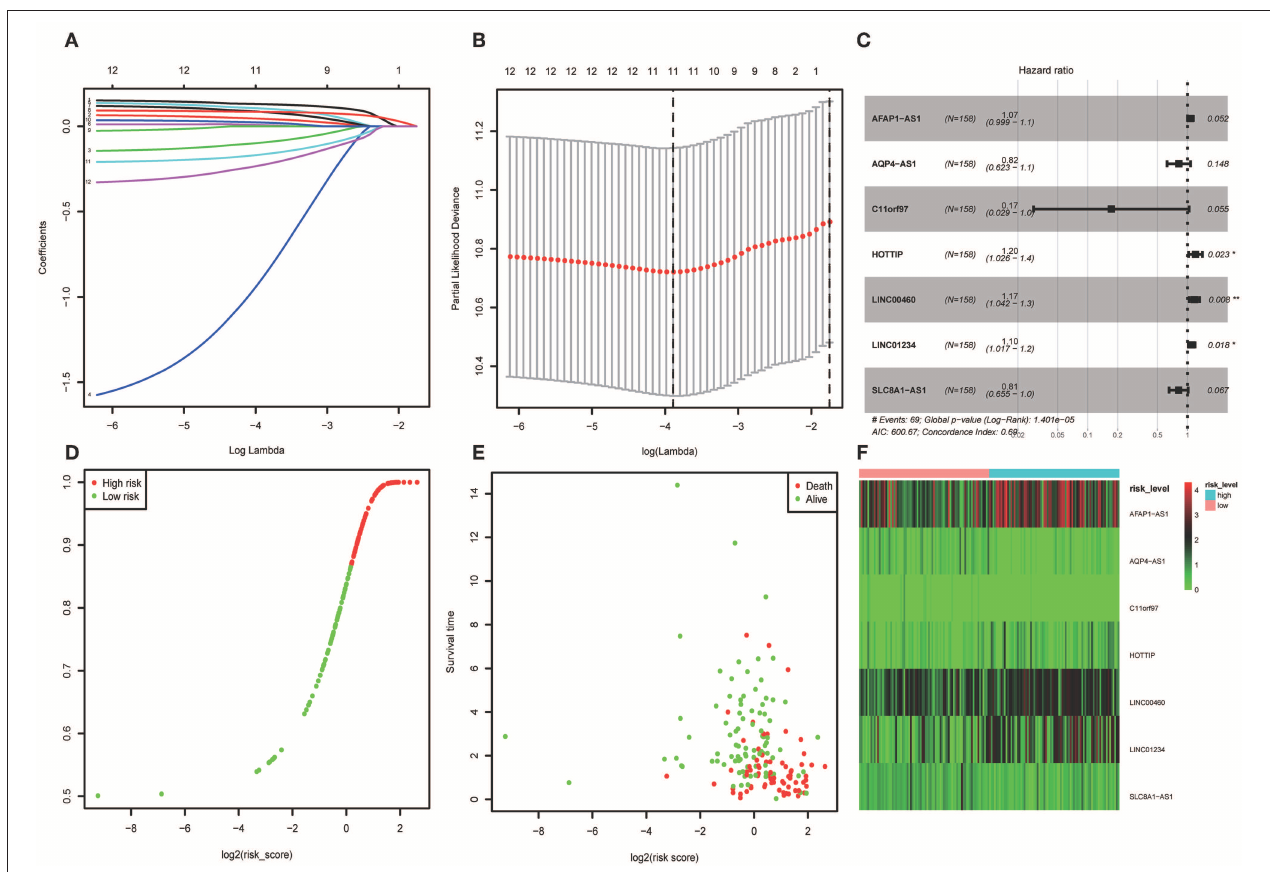
FIGURE 5 | (A) LASSO coefficient profiles of the genes associated with the overall survival of OSCC. (B) Partial likelihood deviance was plotted vs. log(c). The vertical dotted line indicates the lambda value with the minimum error and the largest lambda value, where the deviance is within one SE of the minimum. (C) Forest map based on the risk score model. Left vertical dotted line indicates protective genes and right risk genes. (D) Overview of risk evaluation models. The y axis represents percentage and x axis log2 (risk score). (E) The scatter diagram based on survival time and log2 (risk score). The red means death and green life. The higher log2 (risk score) is, the shorter the time survival. (F) Differentially expressed lncRNAs which were enrolled in the risk model